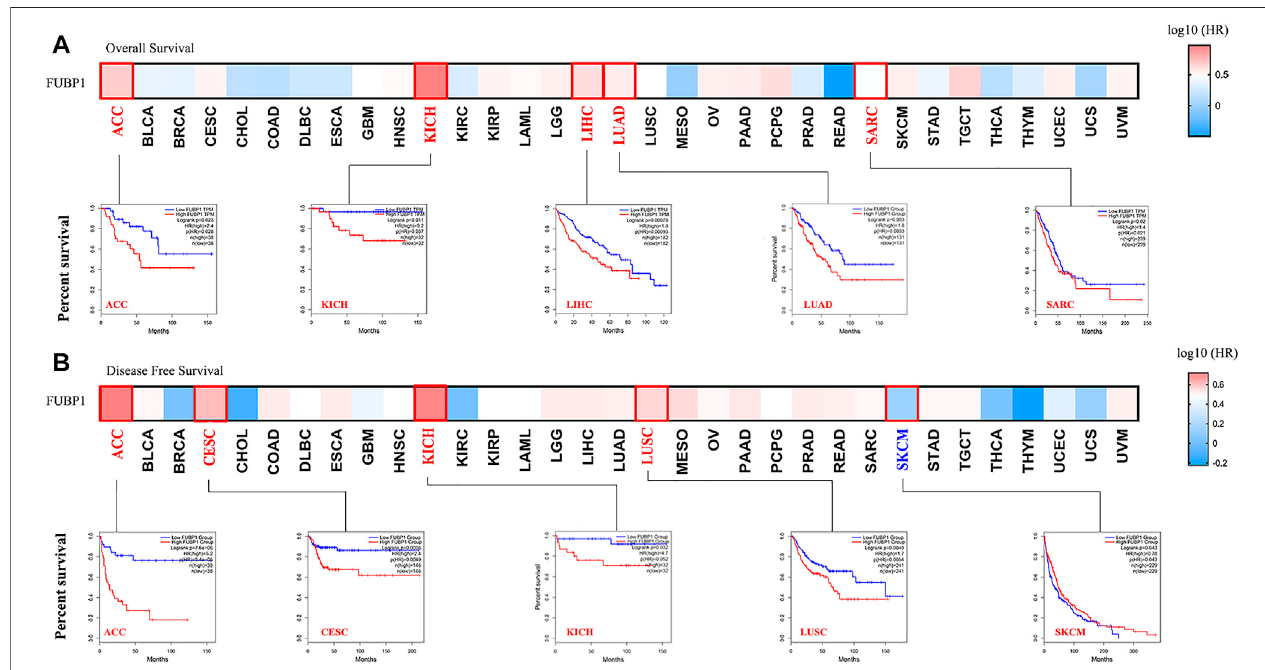
FIGURE2| CorrelationbetweenFUBP1expressionandtheclinicalsurvivalprognosisofdifferentcancersbasedonTCGAdatasets.GEPIA2wasutilizedtoobtain (A) overallsurvivaland (B) disease-freesurvivaldataregardingtheexpressionlevelofFUBP1indifferenttumortypesinTCGA.Kaplan – Meiercurvesweregenerated,and p values less than 0.05 were considered signi fi